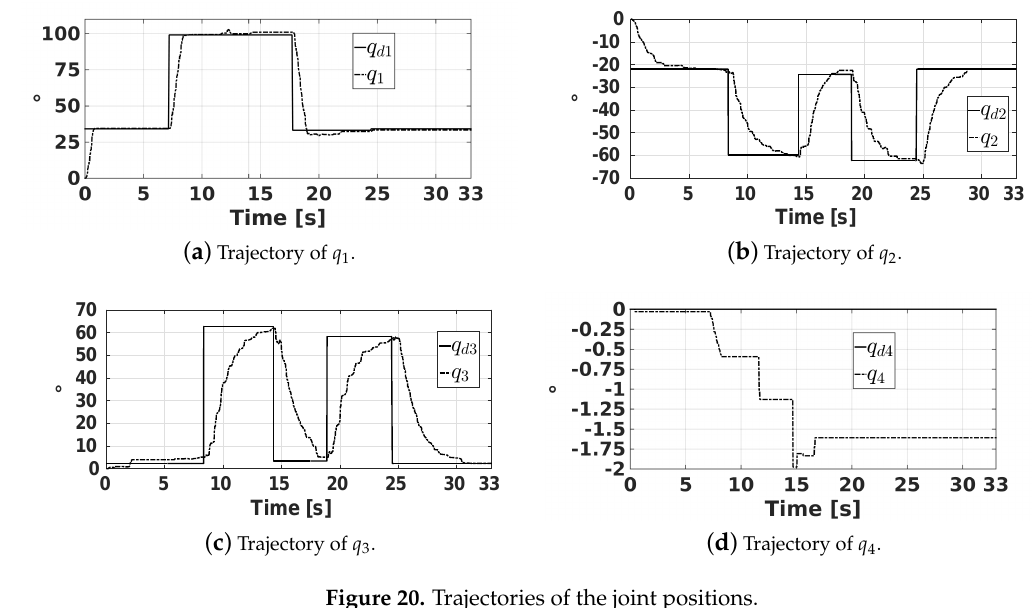
Figure 20. Trajectories of the joint positions.